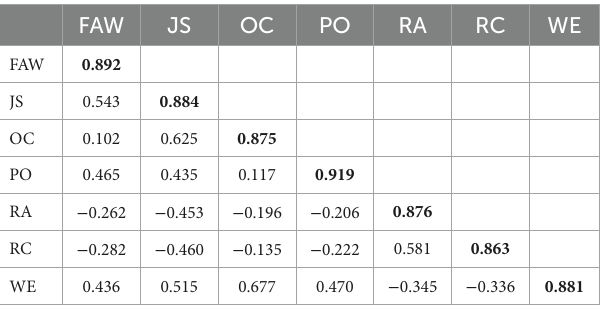
TABLE 5 Variance inflation factor (VIF)